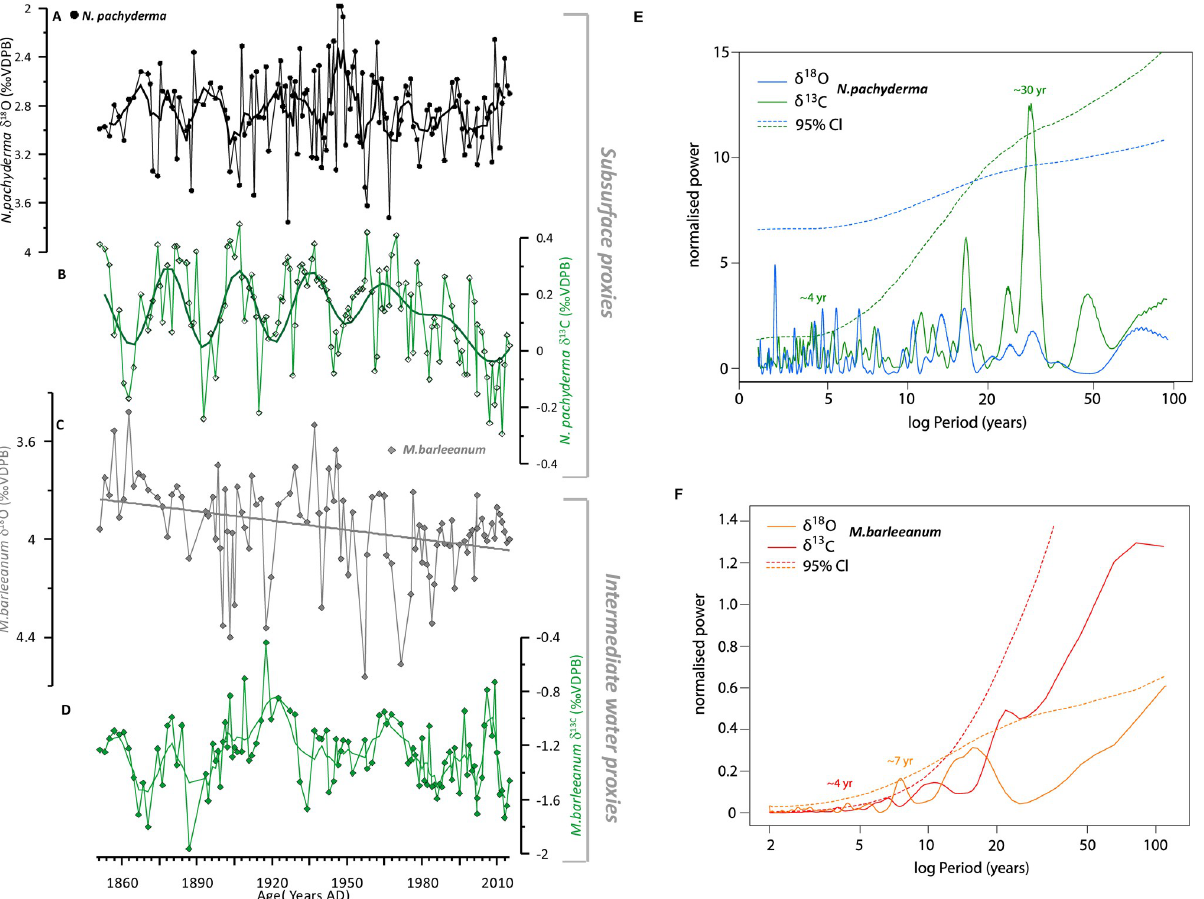
Fig 3. GS15-198 33 marine sediment core climate proxies over the historical time interval. (A) δ 18 O time series of N . pachyderma in black and 5 point running mean (thick line) (B) δ 13 C time series of N . pachyderma in green (raw data) plotted on top the 25-yrs high-pass filter to highlight the significant ~30 cycle identified in the frequency analysis. (C) δ 18 O time series of M . barleeanum (vital effect corrected) in grey, with the long-term trend highlighted as black linear regression (D) δ 13 C time series of M . barleeanum in green (raw data) and 5 point running mean as a thick line. Power spectral density functions of isotopic records for E) N . pachyderma and F) M . barleeanum from core GS15-198-33 using the Lomb-Scargle Fourier transform [57]. The spectra of the data are tested against the theoretical red-noise spectrum computed from simulated 20,000 AR1 series. The dashed curves are the estimated red-noise 95% confidence limits for the respective records. Significant periodicities (95% Cl) are also noted.